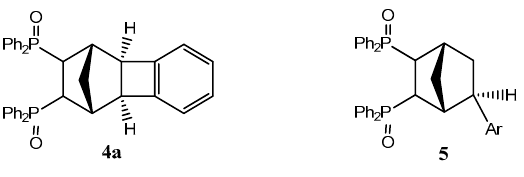
Figure 1. Side reaction products 4a and 5 .